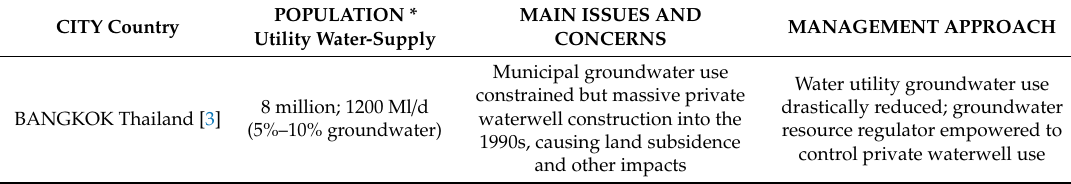
Table 1. Summary of groundwater concerns and management approaches in 10 cities